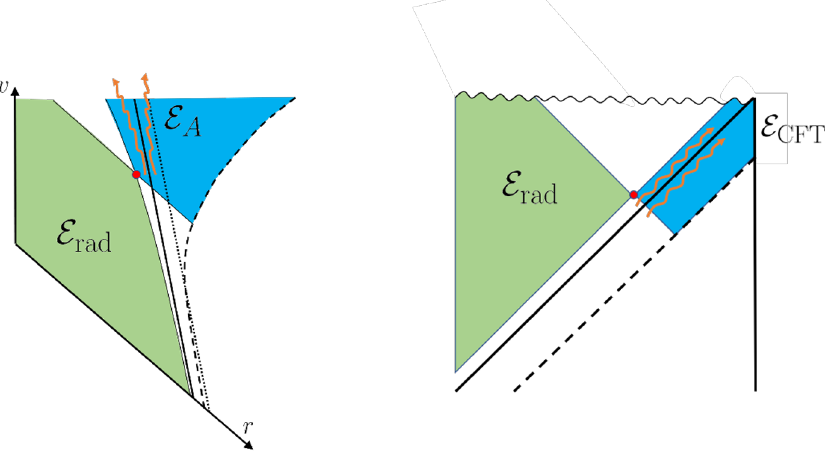
Figure 8. Hawking modes that will escape the black hole only an O ( (cid:12) ) time into the future are entangled with interior modes that are almost entirely in the entanglement wedge of the CFT. This is very di(cid:11)erent from a simple random unitary toy model, but is consistent with toy models where the thermodynamic entropy (i.e. number of qubits) increases over time. (Left: Eddington-Finkelstein coordinates; right: Penrose